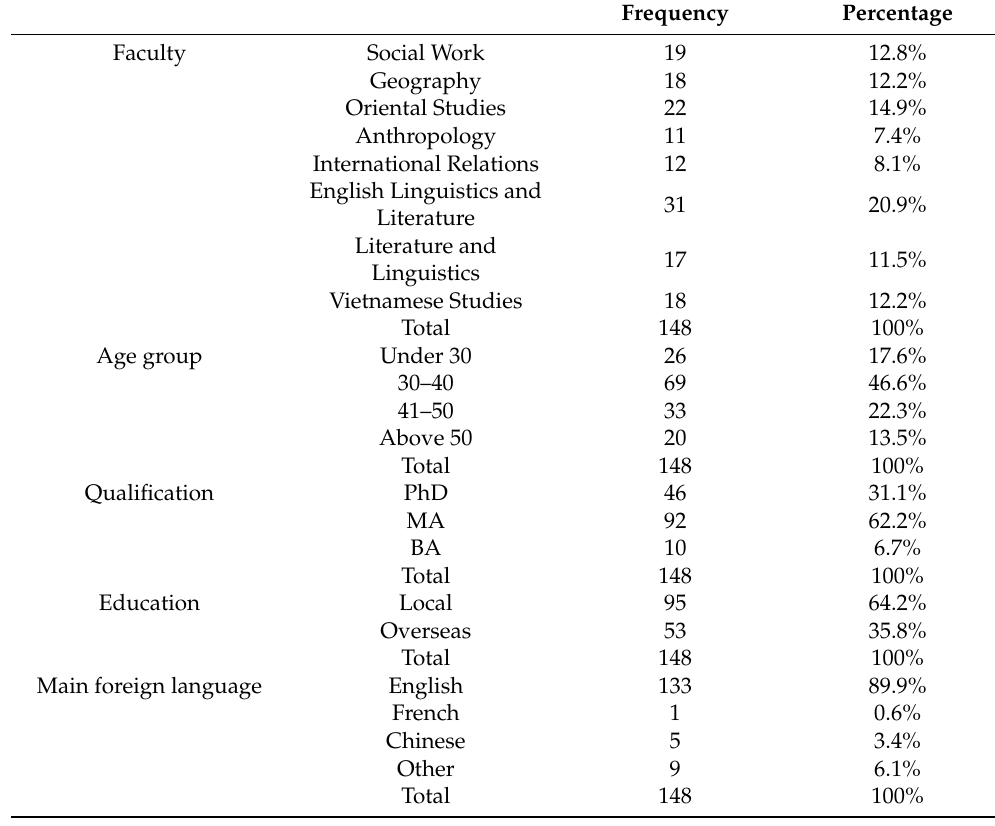
Table 1. Demographic information of